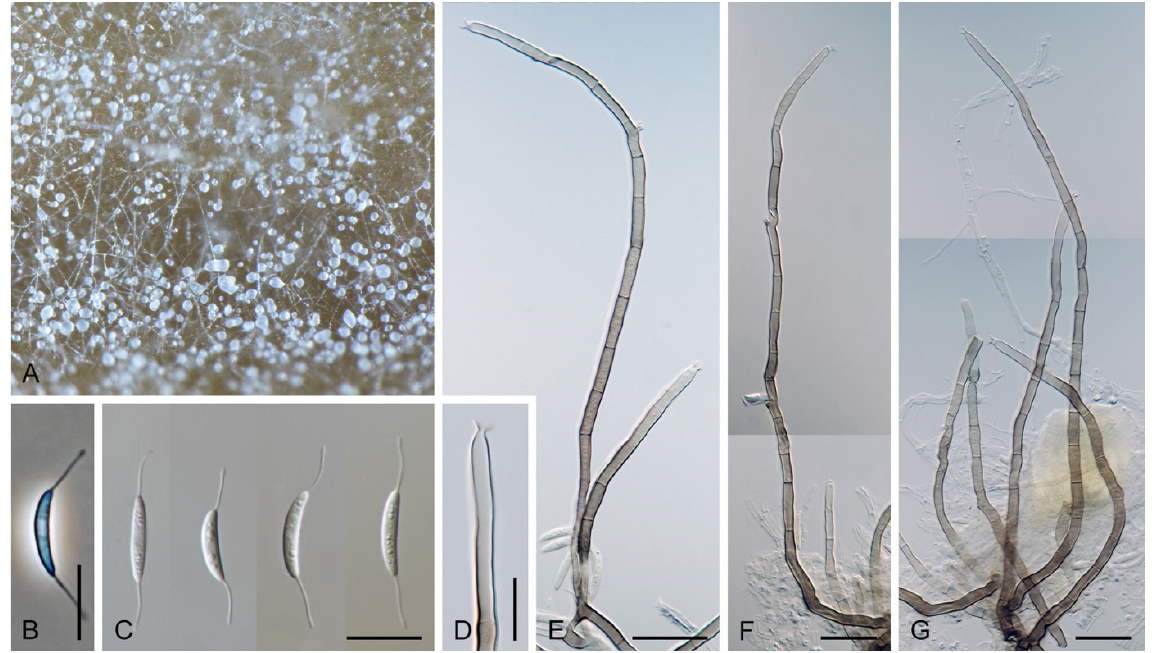
Figure 31. Codinaeella pini (CBS 138866 ex-type). ( A ) Colony ( B , C ) conidia ( D ) conidiogenous cells ( E – G ) conidiophores. Images: ( A – I ) on a stem of U. dioica on CMA after 8 weeks. Scale bars: ( B – D ) 10 μ m; ( E – G ) 20 μ m.